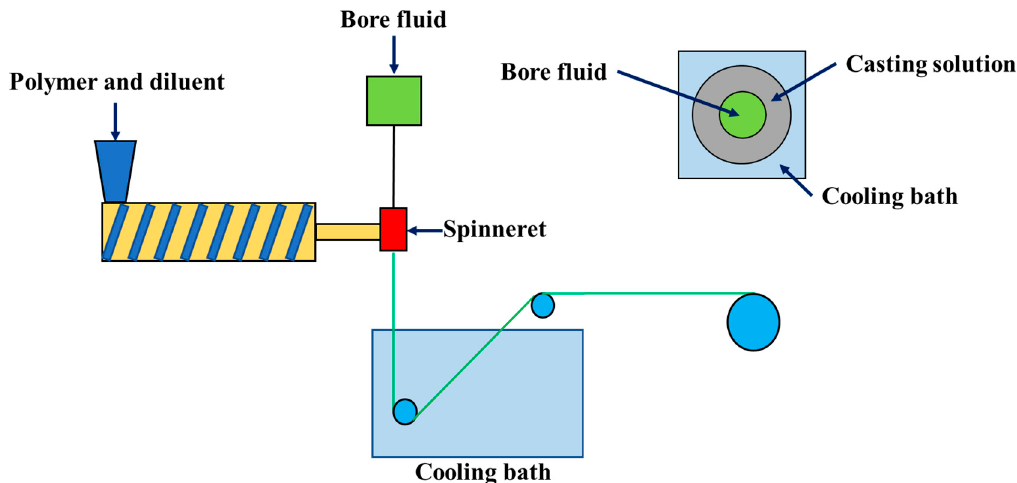
Figure 1. The schematic diagram of the preparation of the PMP HF membranes via the screw extruder system.